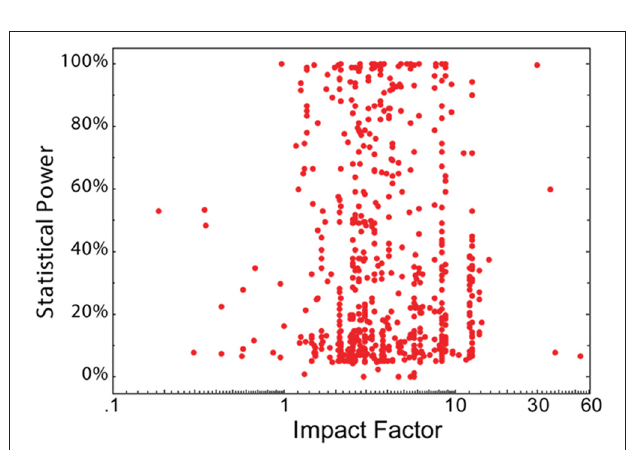
FIGURE 3 | No association between statistical power and journal IF. The statistical power of 650 eligible neuroscience studies plotted as a function of the IF of the publishing journal. Each red dot denotes a single study. Figure from Brembs et al. (2013).